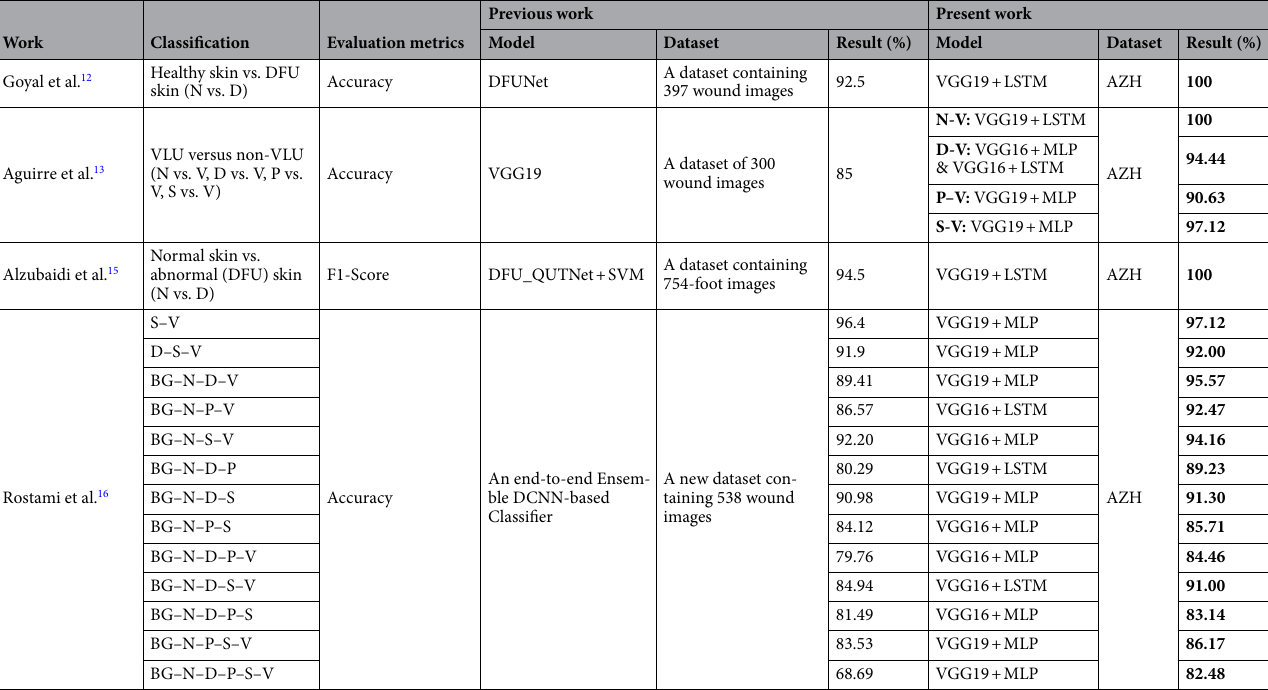
Table 15. Comparison among the previous works and the present work. The bold represents the highest results/accuracy achieved for each